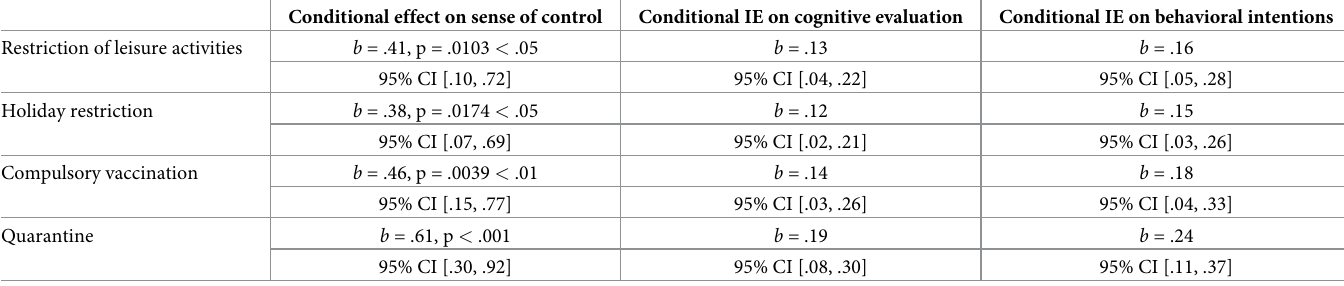
Table 3. Detailed bootstrapping results for the instructions that show the expected effects. Conditional effect on sense of control Conditional IE on cognitive evaluation Conditional IE on behavioral